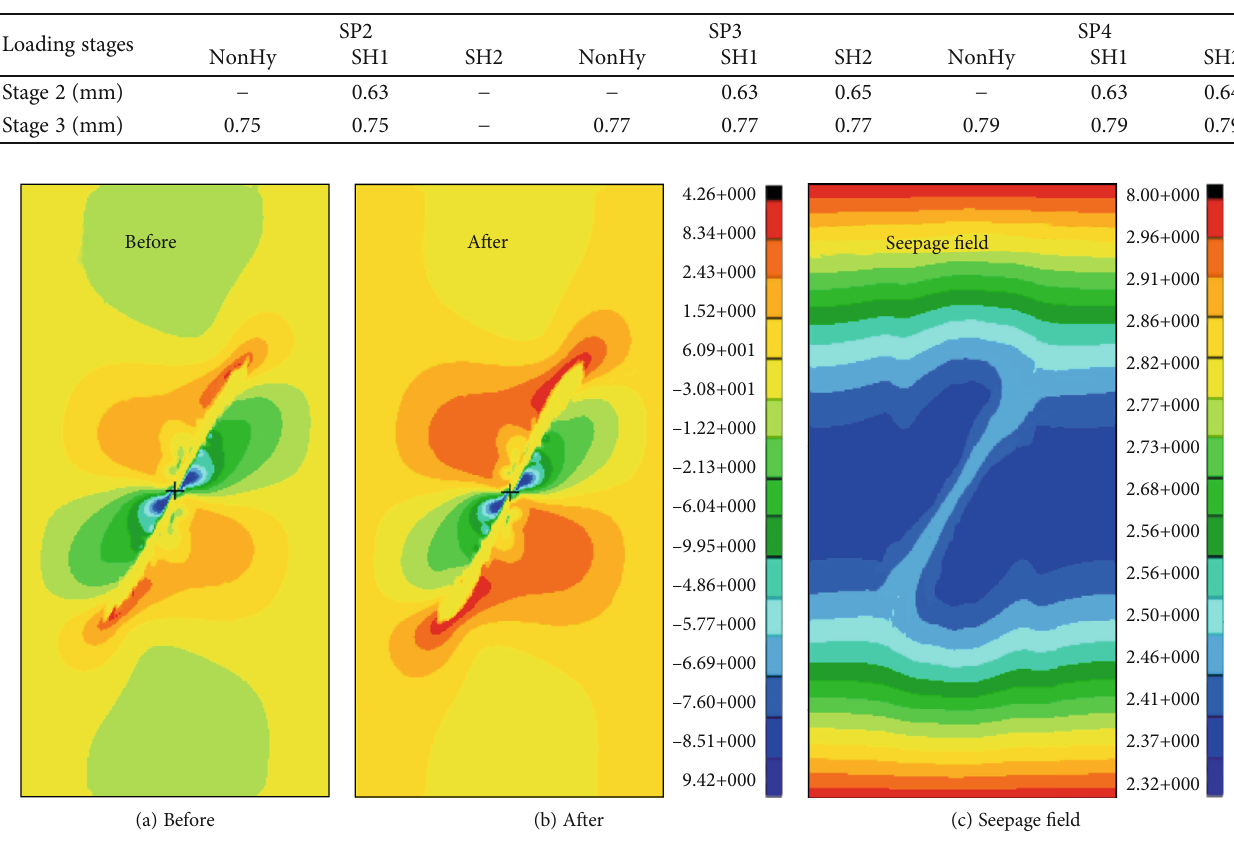
Table 2: Process of the mechanical-hydraulic loading.